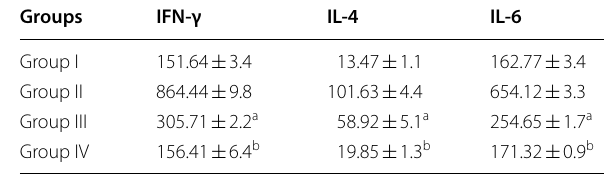
Table 6 levels of cytokines in serum samples of different experimental